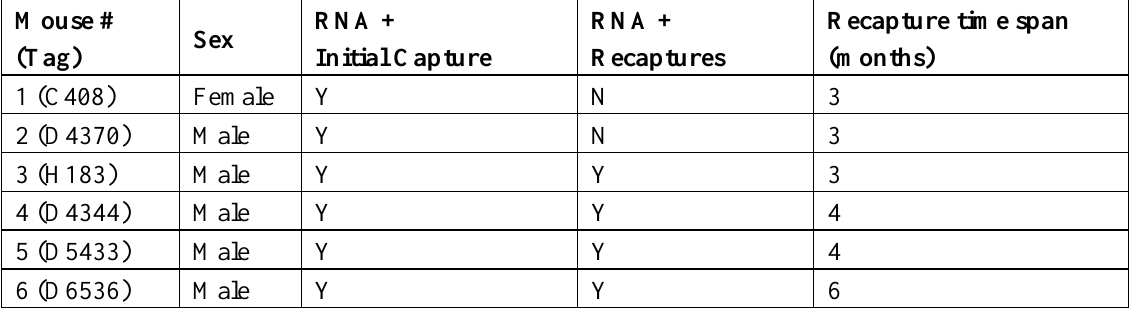
Table 2. Detection of Sin Nombre virus RNA in antibody-positive North American deer mice captured and sampled on three or more monthly trapping